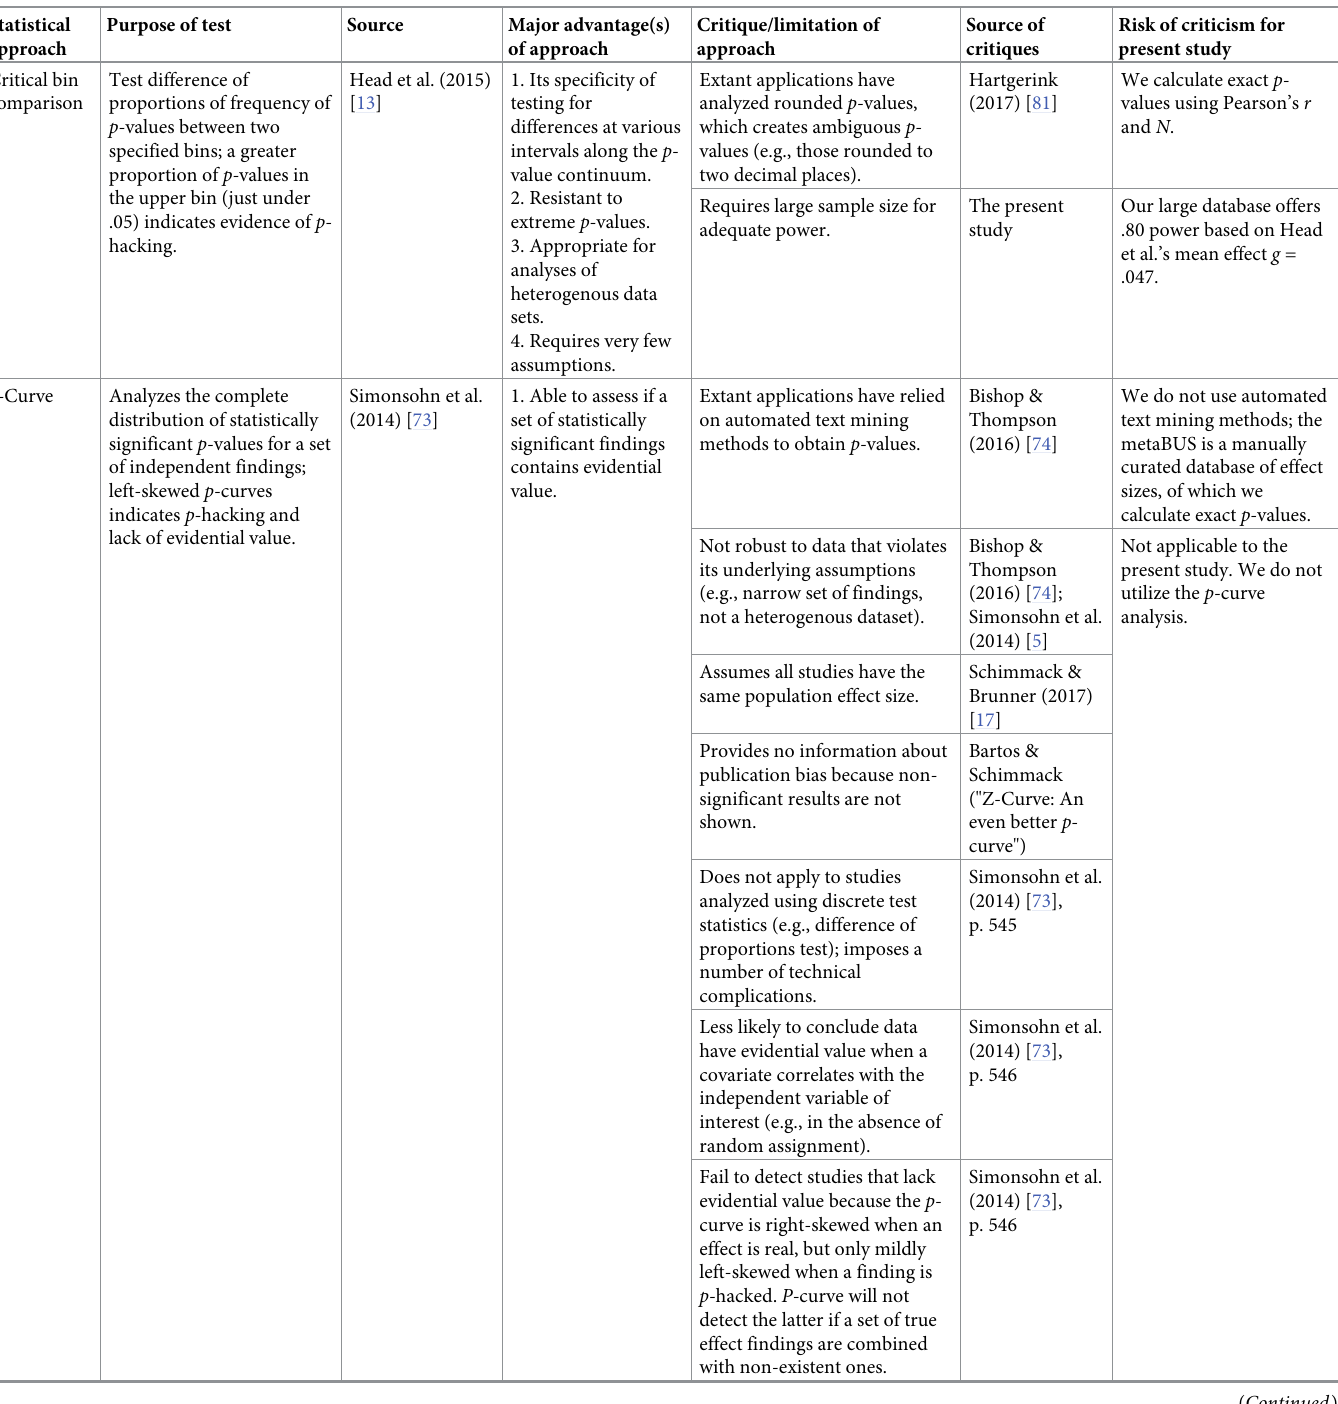
Table 1. Approaches to detect p-